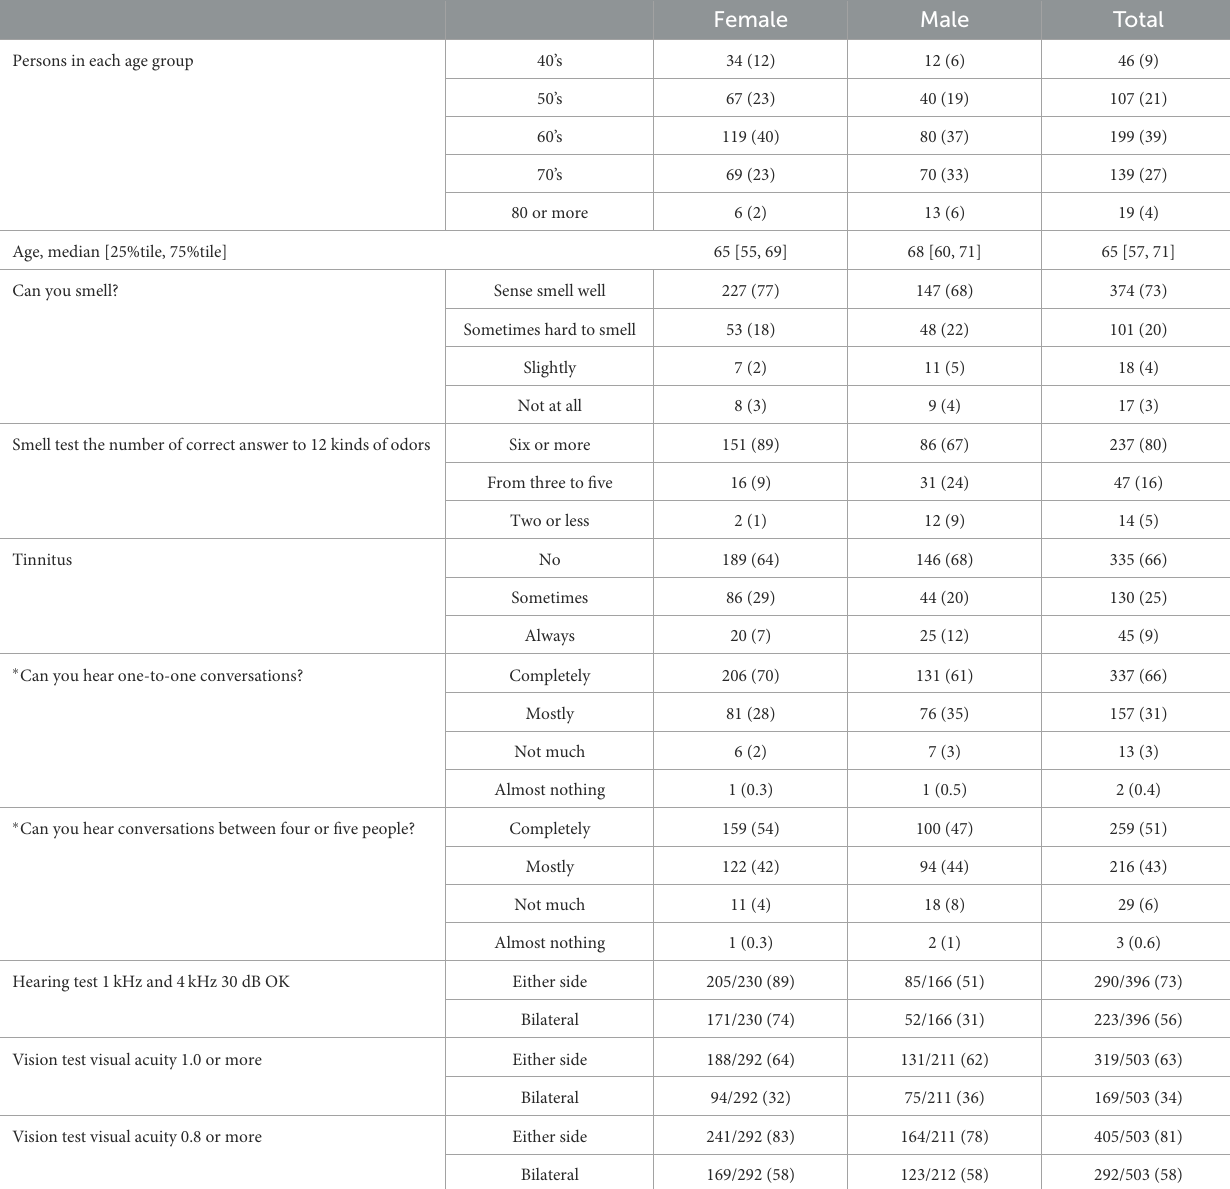
Female Male Total